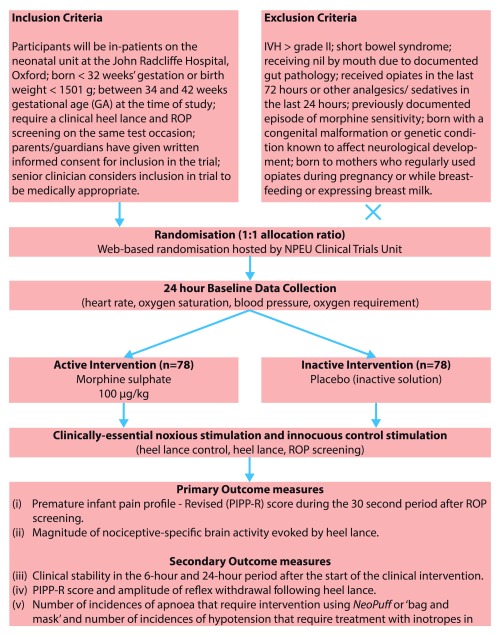
Trial flowchart.